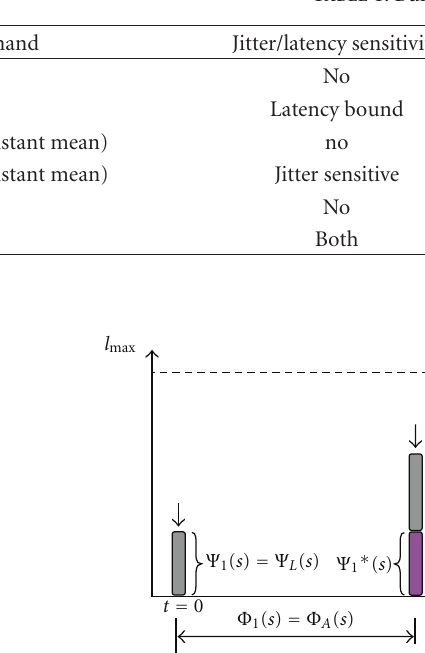
Table 1: Burst generation characteristics.